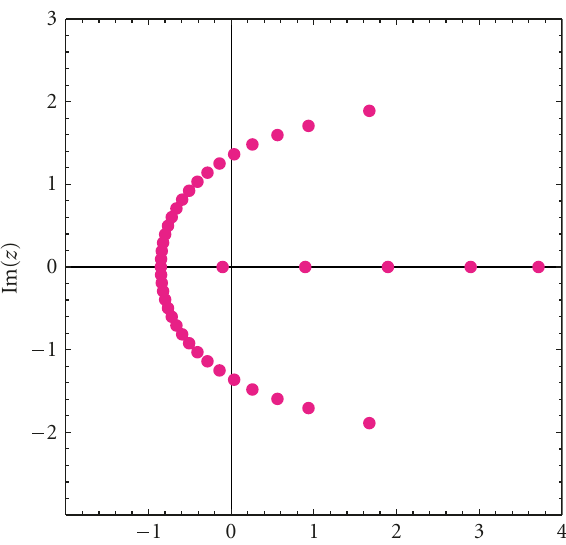
Figure 4.3 . Zeros of E 30, q , w ( x ).